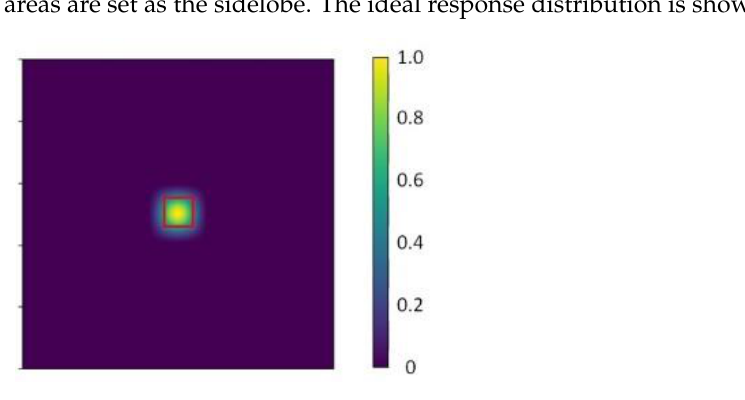
Figure 4. Ideal response distribution.